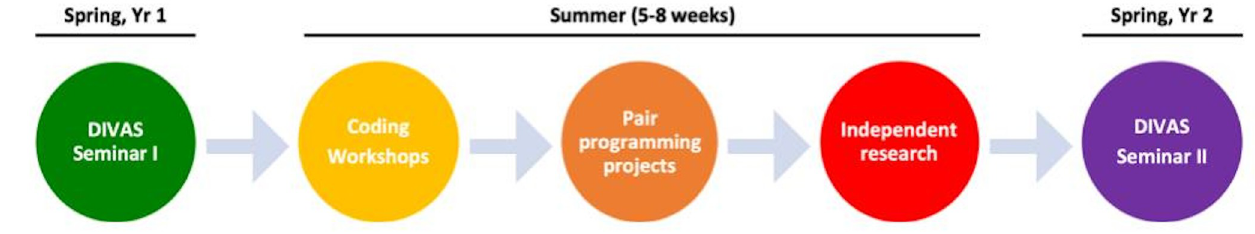
Fig 1. Interventions comprising the computational ‘onramp’ of the DIVAS